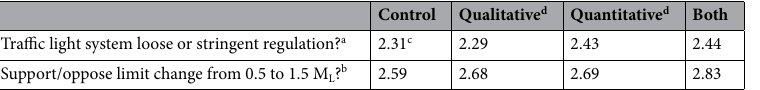
Table 1. Wave 1 survey: policy support across information conditions. a Five-point bipolar scale, with don’t know (DK = 31%) (1 = Far too loosely, 2 = Somewhat loosely, 3 = About right, 4 = Somewhat stringently, 5 = Far too stringently). b Six-point bipolar scale, with don’t know (DK = 31%) (1 = Strongly oppose, 2 = Moderately oppose, 3 = Slightly oppose, 4 = Slightly support, 5 = Moderately support, 6 = Strongly support). c Following ANOVA tests/, we ran Tukey post-hoc tests for differences between means of the two policy-relevant attitudes, across the four treatment conditions. Results revealed no significant differences. d See methods for text of qualitative and quantitative information provision.